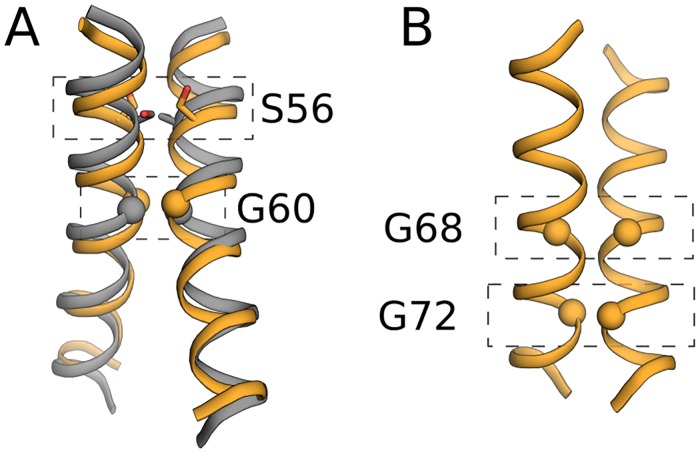
Low-energy predicted models of ErbB2 recapitulate two binding modes thought to underlie receptor activation.(A) The ErbB2 experimental structure (PDB entry 2JWA, grey) and a representative of the second-best cluster (orange). (B) The fourth-best cluster (orange), RMSD 5.8 Å from 2JWA, exhibits a right-handed conformation in which Gly68 and Gly72 are buried, in qualitative agreement with experiments [53] and modelling [54].